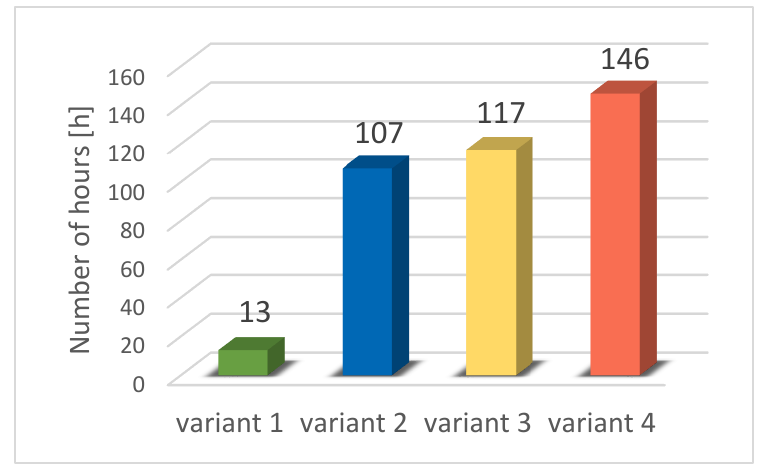
Figure 11. Degree-hours of discomfort for the four simulation variants.